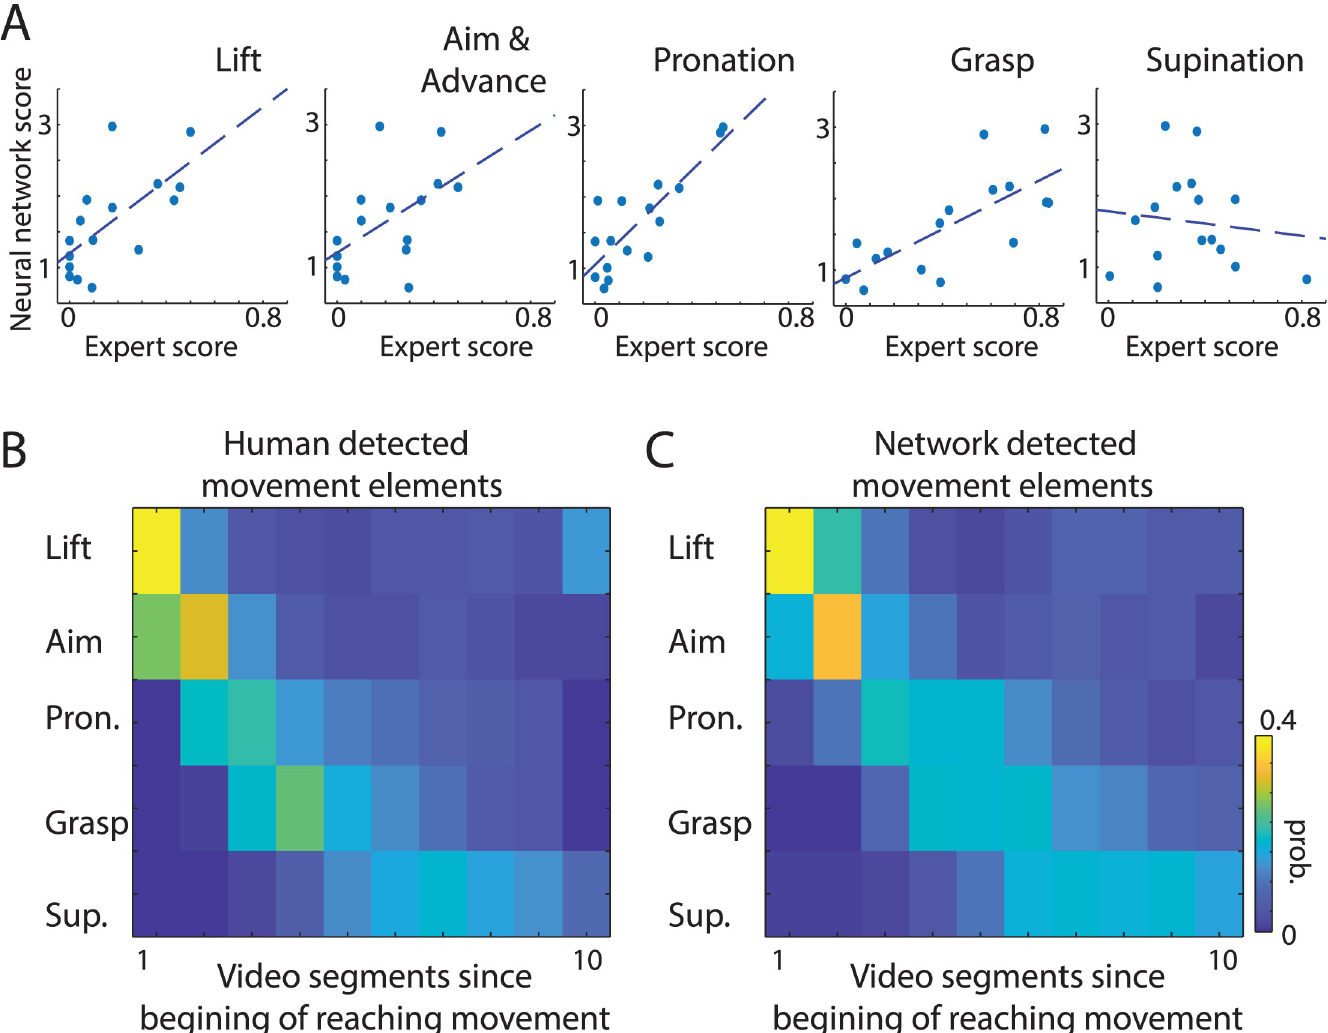
Fig 3. The network can learn to detect individual movement components with human-level accuracy. (A) The relation between network scores and expert scores for individual movement components. Each dot represents the average score for one rat, and dashed lines show linear regression. Network scores were significantly correlated with expert scores for almost all movement elements. (B, C) To directly test whether the network could learn to discriminate movement components in action clips, we retrained the network on video segments with labeled movement elements. Panels B and C show the probability (“prob.”) of detecting a particular movement element in a video clip. For visualization, video segments are aligned with respect to the beginning of a reaching movement. The high similarity between timing of movements defined by the expert (B) and the network (C) shows that the network can be used for automated segmentation of behavioral videos to identify specific movements. The sample network and data on which this figure is based are available at github.com/hardeepsryait/behaviour_net. Pron., pronation; Sup., supination.